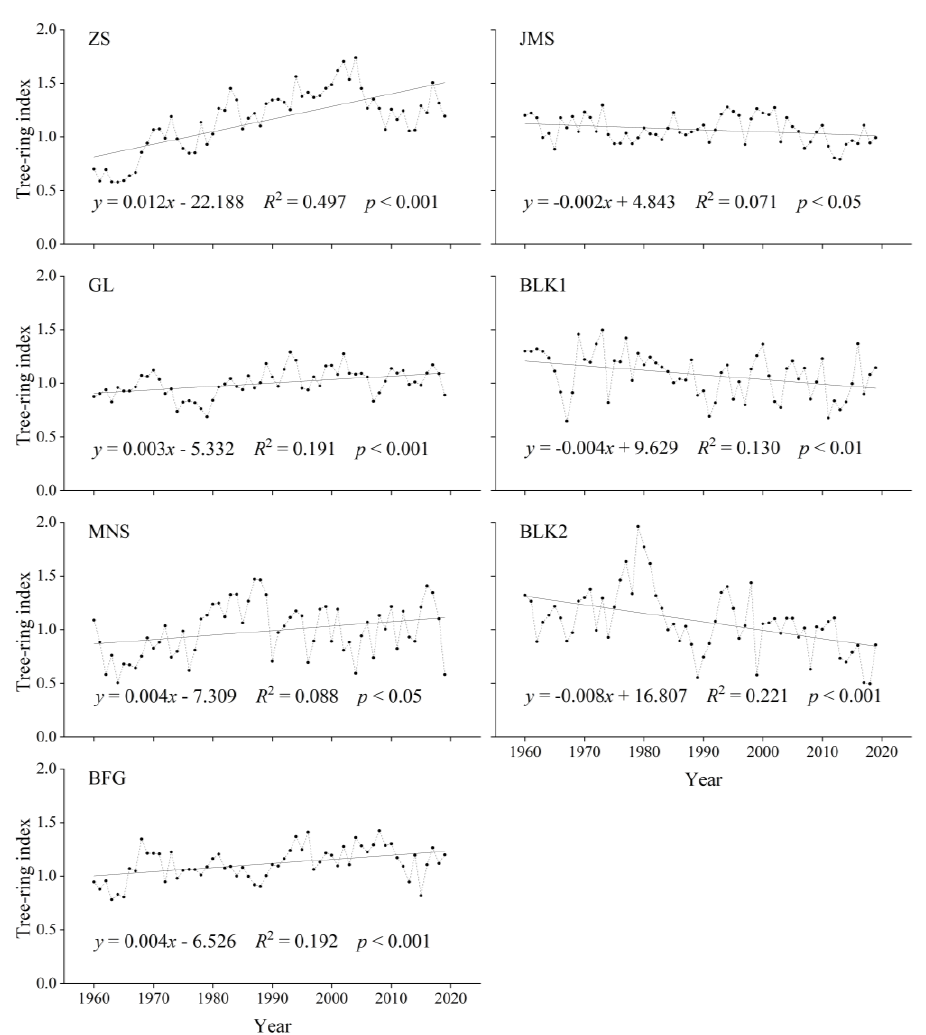
Figure 4. Standard chronologies during 1960–2019 at seven sites in the Tianshan Mountains.